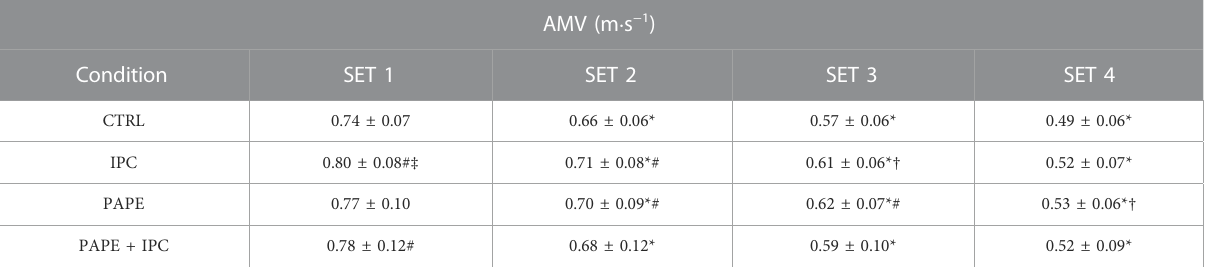
TABLE 1 The average mean barbell velocities (AMV) in each experimental condition. CTRL: control; IPC: ischemic pre-conditioning; PAPE: post-activation performance enhancement; PAPE + IPC: post-activation performance enhancement and ischemic pre-conditioning.